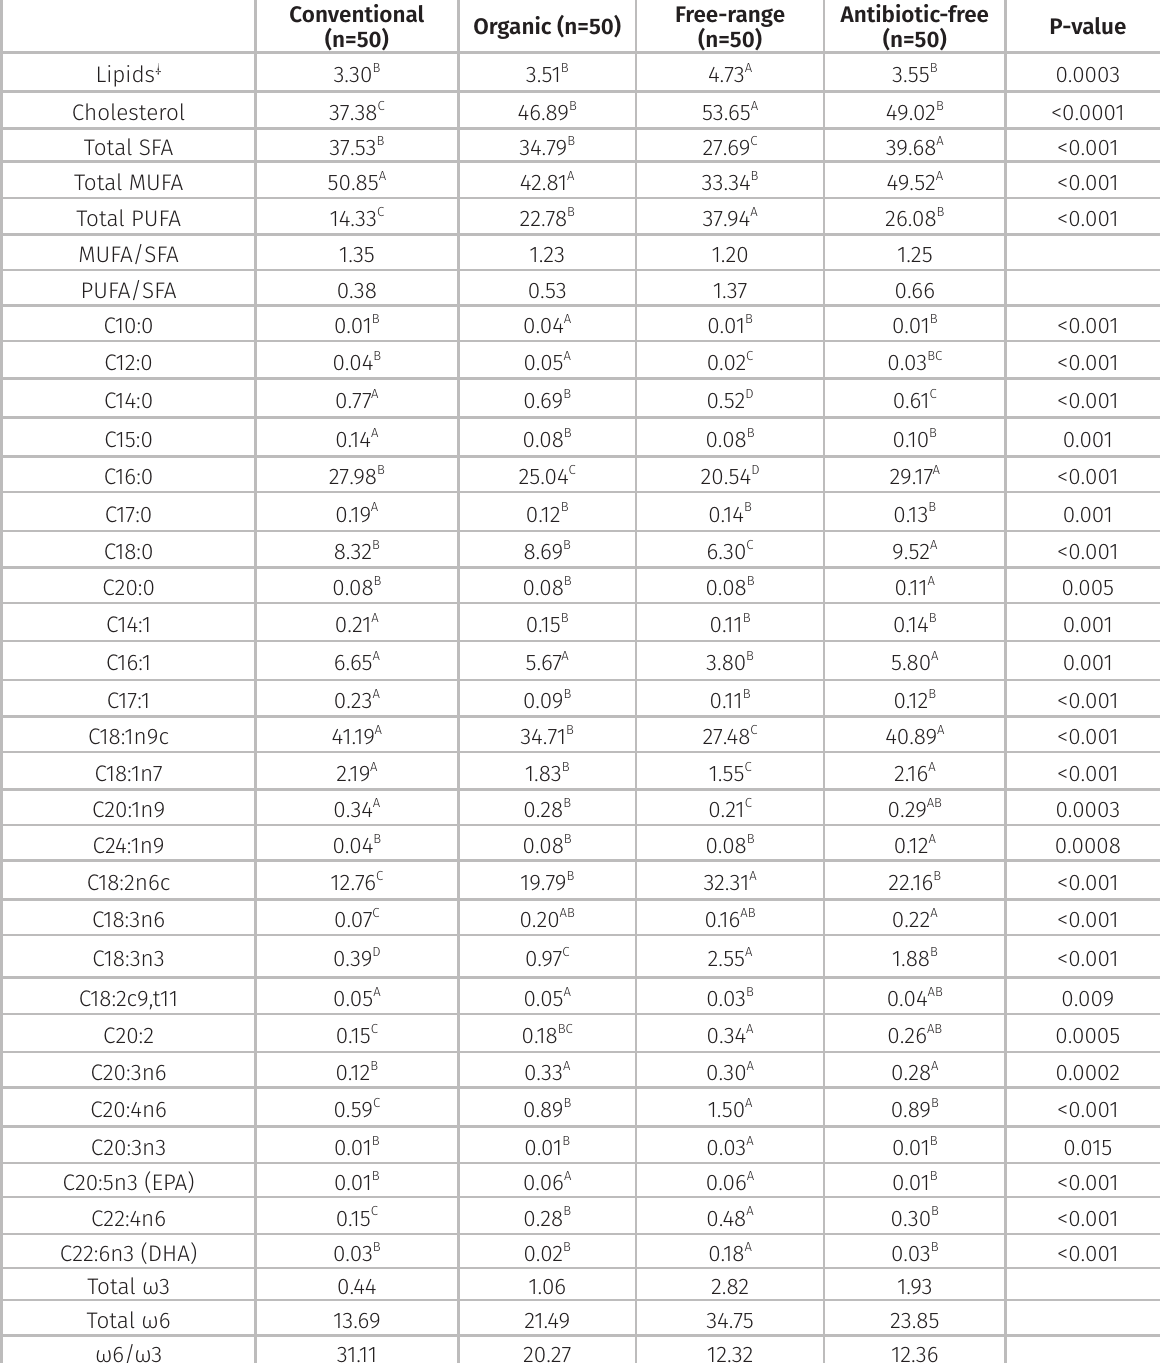
Table IV. Lipids (%) and cholesterol (mg/100g) of drumstick meat and fatty acid composition (% of total fatty acids) of fat from drumstick meat from broilers raised in different rearing